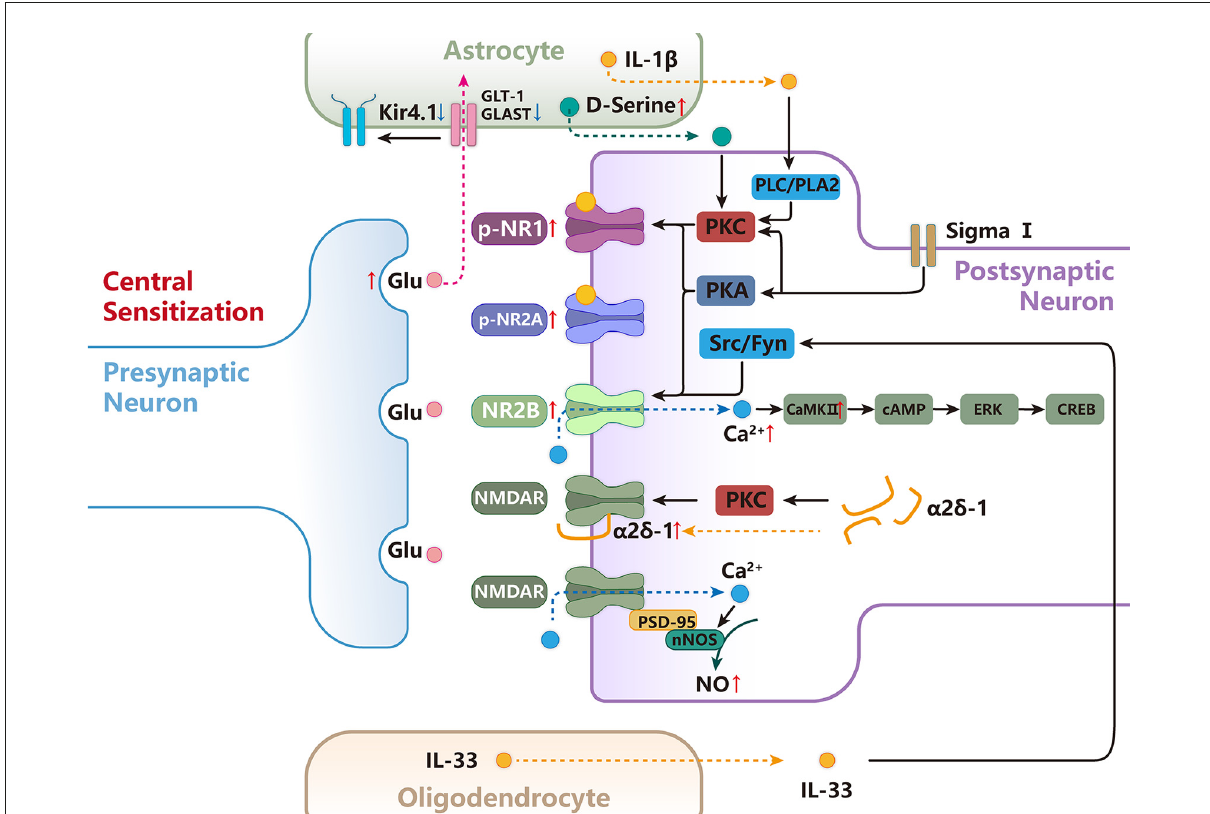
FIGURE4 The functional role and mechanisms of NMDARs in regulating central sensitization of orofacial pain. D-Serine released from astrocytes increases PKC-dependent NR1 phosphorylation, contributing to central sensitization. Activation of the sigma-1 receptor enhances NMDA-induced pain via PKC- and PKA-dependent phosphorylation of the NR1 subunit. Src and Fyn can promote the phosphorylation of GluN2B at Tyr1472, resulting in up-regulation of NMDAR activity and membrane localization.NR2B/CaMKII acts as an upstream cascade to facilitate cAMP production and ERK-CREB activation after inflammatory and nerve injury in the SpVc. NMDAR forms a heteromeric complex with α 2 δ -1 in the spinal cord, and the α 2 δ -1-NMDAR interaction promotes surface trafficking and synaptic targeting of NMDAR. α 2 δ -1 can also indirectly regulate NMDAR through PKC.PSD-95 couples nNOS to NMDAR to form an NMDAR-PSD95-nNOS complex, which produces NO and leads to central sensitization. Astrocytes are responsible for the majority of glutamate uptake, which occurs mainly through two transporters, GLT-1 and GLAST, and Kir4.1 functions in the facilitation of astrocytic glutamate uptake. IL-33 act on the postsynaptic neuron to promote the phosphorylation of NR2B through activation of Fyn. the intracellular signal pathway of PLC, PLA2, and subsequent PKC activation is involved in the astrocyte-derived IL-1 β -induced NR1